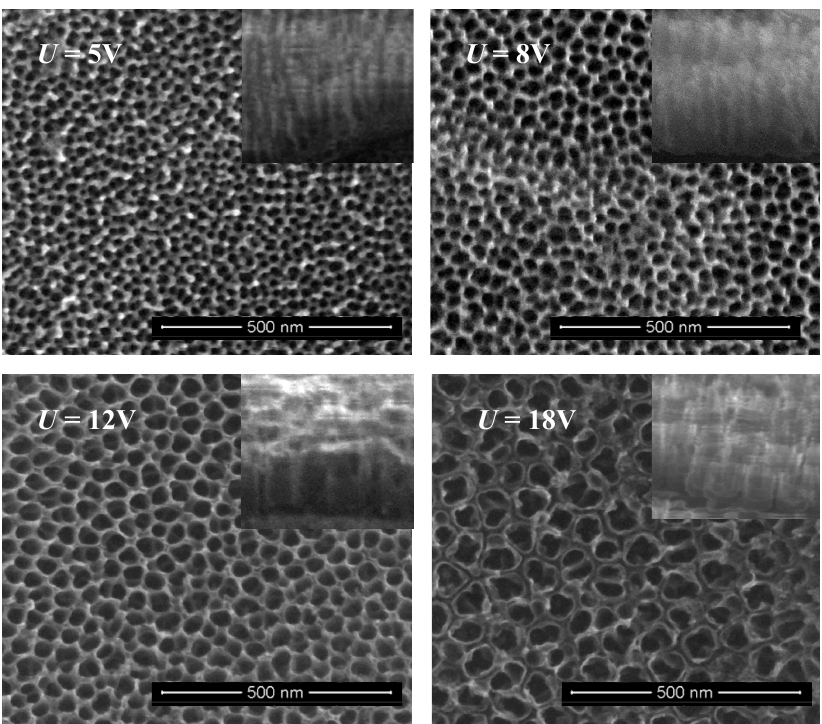
Figure 1. SEM (Scanning Electron Microscopy) images of the surface morphology and the cross section of titania nanotube (TNT) coatings on the surface of Ti6Al4V foil, produced at 5 V, 8 V, 12 V, and 18 V. Cross sections of the TNT coatings are illustrated as